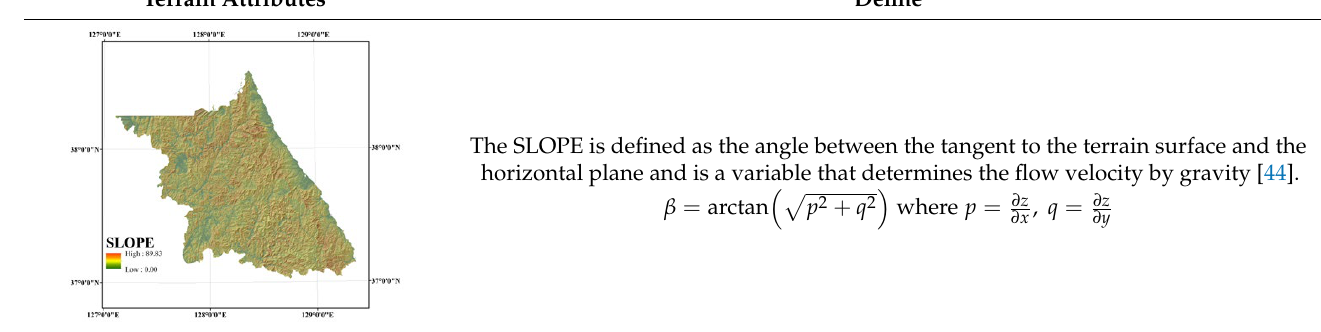
Table 1. Definition of Terrain Attributes in the study area and its derived results. Terrain Attributes